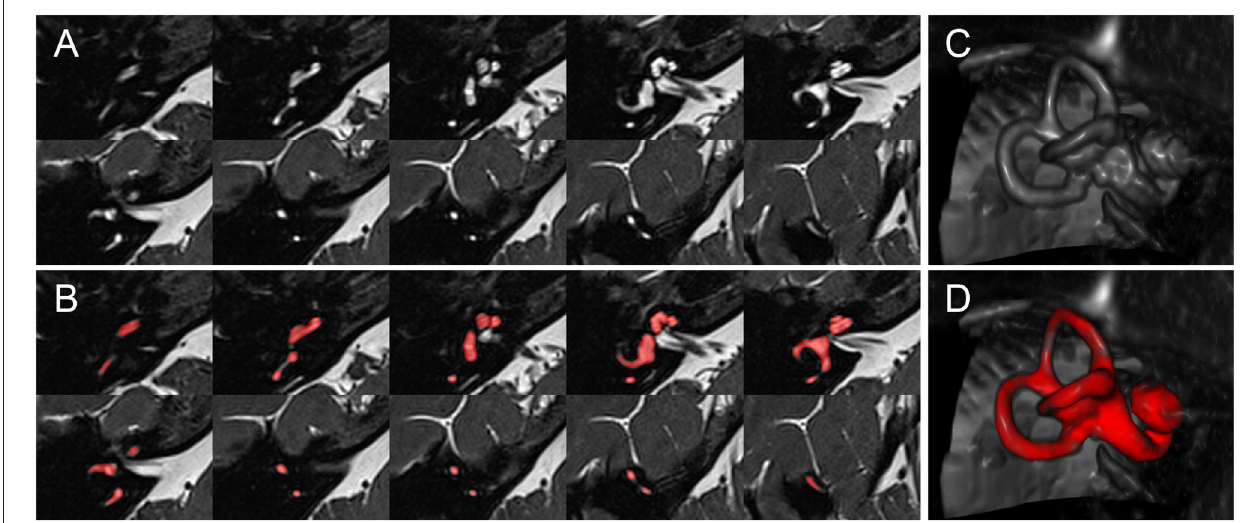
FIGURE 2 | Inner ear MR example case. Depiction of an exemplary SPACE volume along with its ground-truth segmentation masks. (A) Depiction of ten axial slices from the SPACE MRI sequence volume, through the right inner ear, from caudal to cranial, covering a range of 12.4 mm ( ∼ 1.4 mm slice distance). (B) Like (A) , but with the manually segmented total fluid space (TFS) mask (colored in red). (C) Volume rendering of the right inner ear ROI, which serves as input to the IE-Vnet model. (D) Like (C) , but the manually segmented TFS surface overlaid in